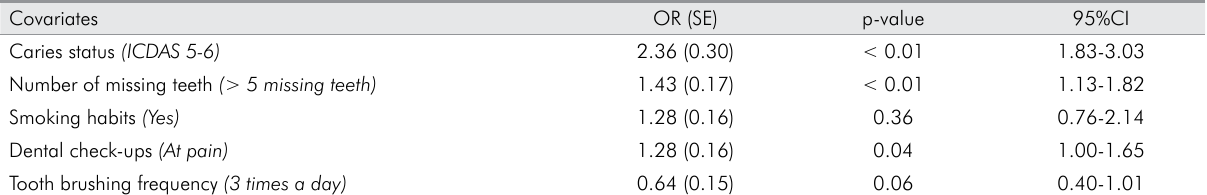
Table 3. Multinomial logistic regression estimates for significantly associated caries risk covariates to Cariogram scores.